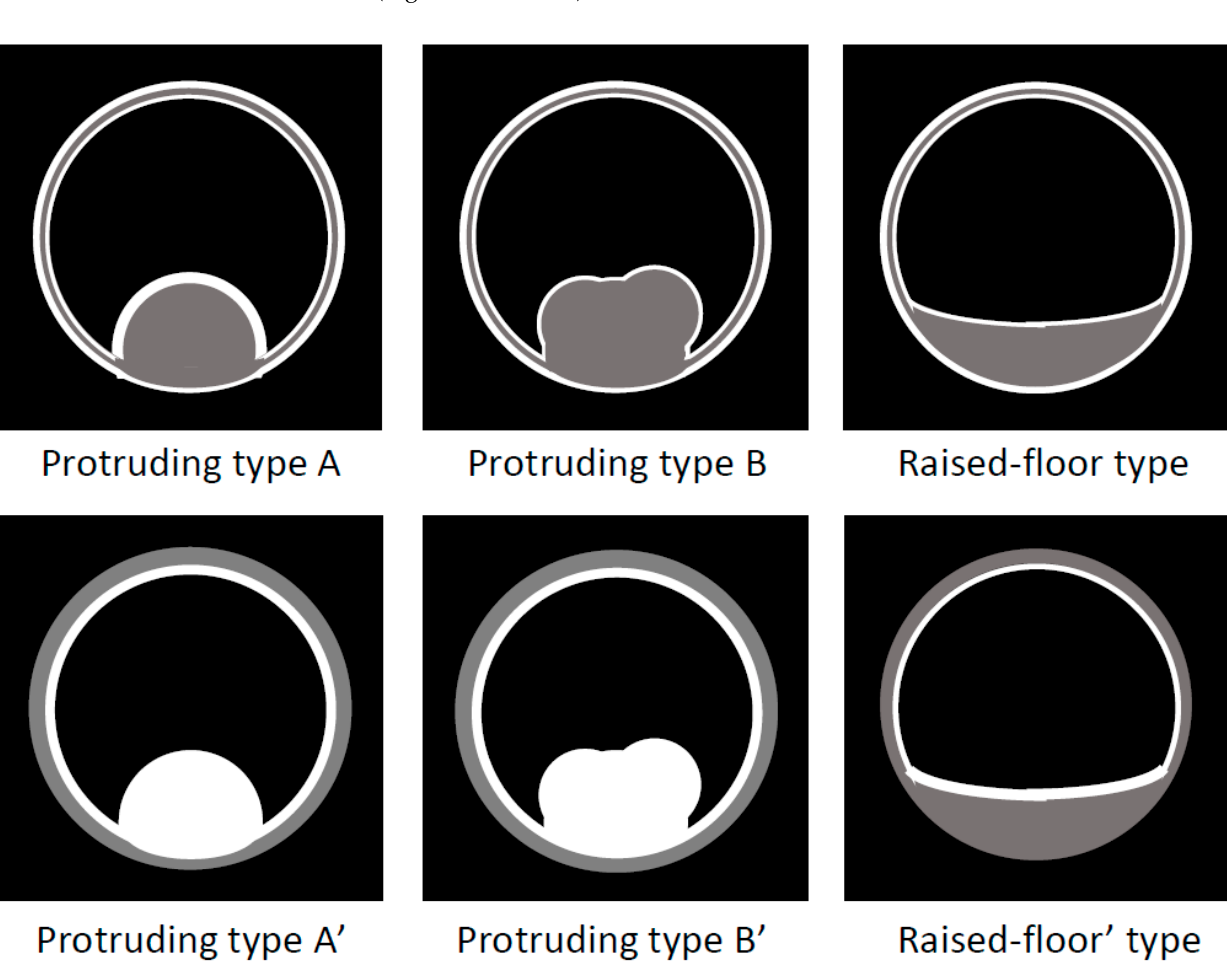
Figure 11. Schema of CT findings in a localized type of IgG4-sclerosing cholecystitis. A localized IgG4-CC could be classed into the protruding type A (with smooth and contrast-enhancing surface); -A’ (with smooth surface and homogenous CE); -B (with nodular and contrast-enhancing surface); -B’ (with nodular and contrast-enhancing surface lined by a homogenously thickened outer layer); raised-floor type (with contrast-enhancing surface); raised-floor’ type (without contrast-enhancing surface).